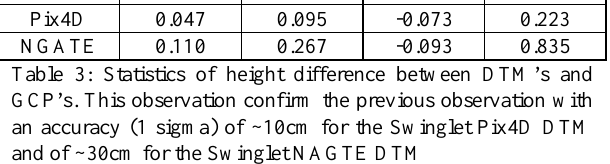
Figure 7: Height difference map between NGATE and LIDAR DSM. The circle fence the area where GCP’s are located. In this area, the height difference on smooth terrain ranges of 40cm. On the left side of the graphics, the difference increases